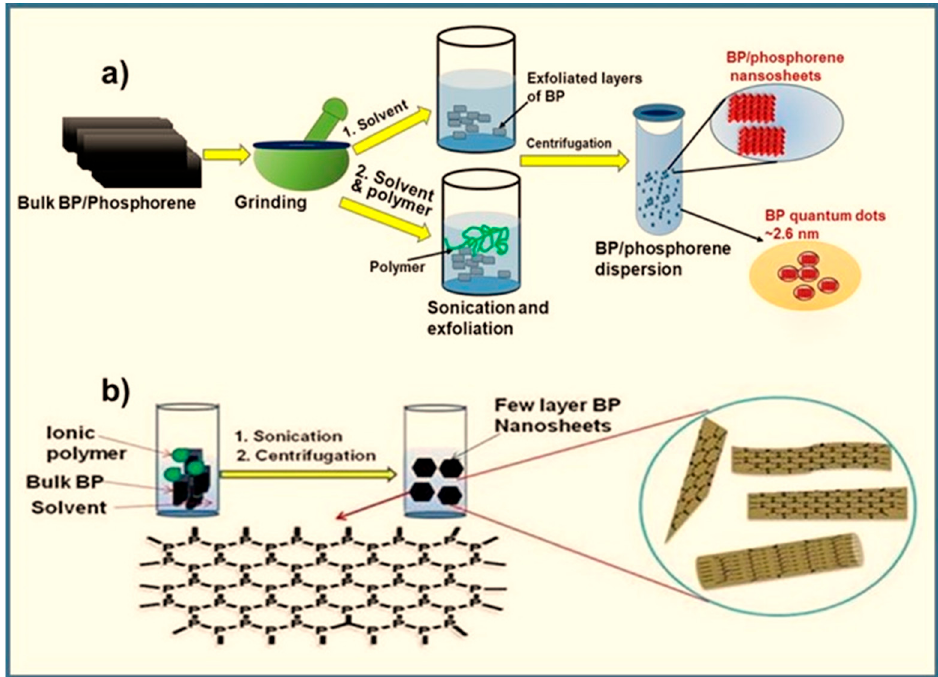
Figure 1. ( a ) Synthesis of nanosheets and quantum dots of black phosphorus or phosphorene via solvent exfoliation in the presence of a polar/nonpolar solvent and a suitable polymer. ( b ) Exfoliation in the presence of a solvent and polymer. During exfoliation, the molecules of solvent and polymer can penetrate the layers and thus assist in unzipping the multilayer of BP under stress caused by the sonication. The type of solvent, sonication, and time can significantly determine the shape and size of resulted nanosheets. At the bottom, a chemical structure of single phosphorene nanosheet is shown. Copyright 2020, the Materials Research Society, reproduced with permission from the